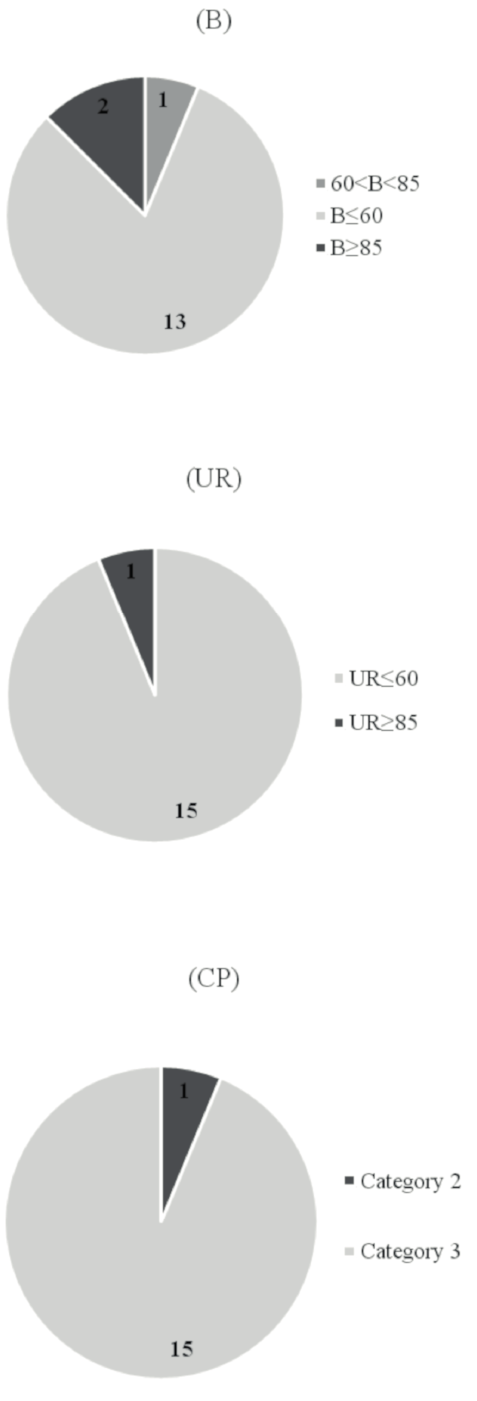
Figure 2 - Scores of Biological Value (B) and Use Risk (UR), as well as categories of Conservation Priority (CP) of the sixteen My rtaceae species cited by rural dwellers of the mountain region of Espírito Santo,